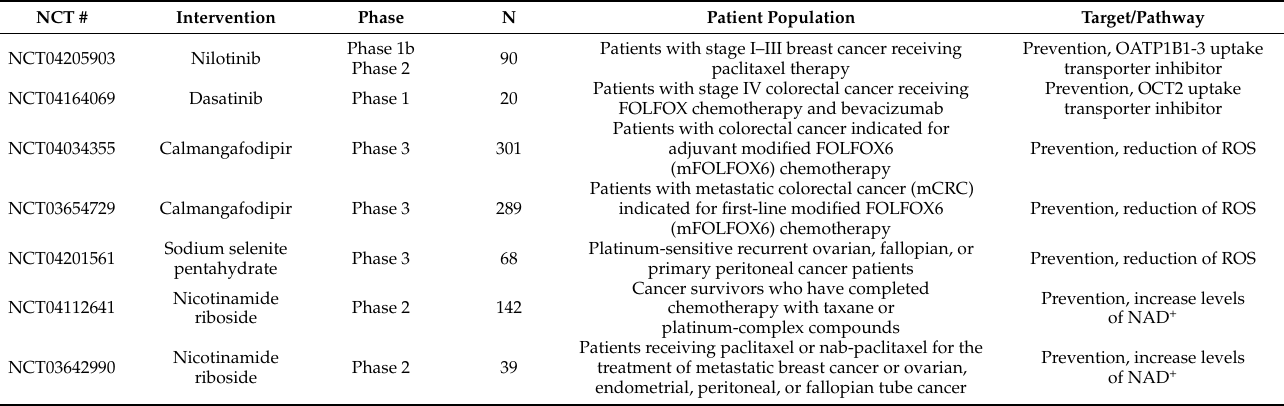
Table 1. List of emerging clinical trials for the prevention and treatment of chemotherapy-induced peripheral neuropa- thy